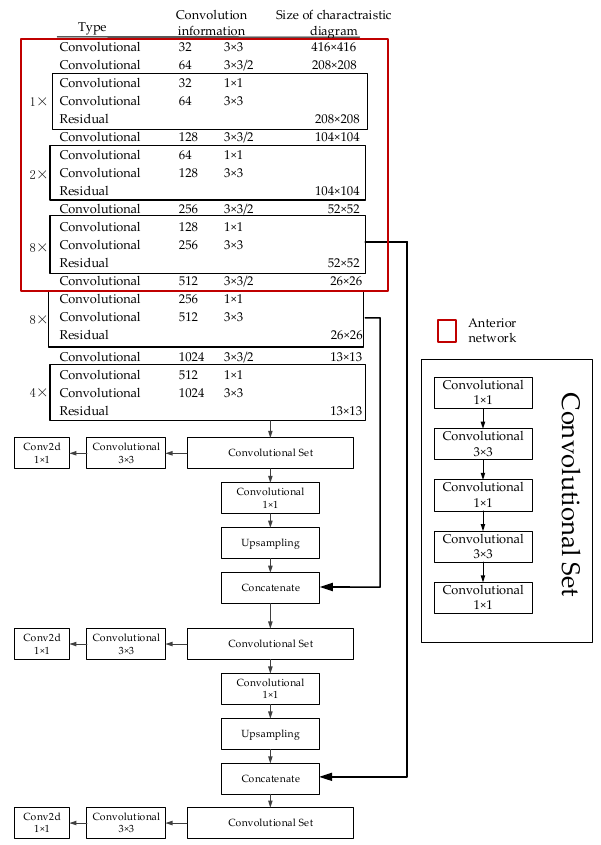
Figure 6. Network structure and network split results.